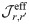
Relative changes in interaction strength due to hidden neurons for three network types.We quantify relative changes in interaction strength between effective (Jr,r′eff) and true (Jr,r′) interactions by the (sample) root-square-mean deviation, σ[Jr,r′eff-Jr,r′], normalized by the true synaptic weight (sample) standard deviation σ[Jr,r′]. We do so for three (sparse) network types: Left. An Erdős-Réyni (ER) network with “mixed synapses” (i.e., Dale’s law not imposed) with normally distributed synaptic weights. Middle. An ER network with Dale’s law imposed, (i.e., each neuron’s outgoing synaptic weights all have the same sign). Right. A Watts-Strogatz (WS) small world network with 30% rewired connections and mixed synapses. All network types yield qualitatively similar results. In each plot solid lines are numerical estimates of the sample standard deviation of the difference between effective coupling weights Jr,r′eff and true coupling weights Jr,r′ between neurons r ≠ r′, normalized by the standard deviation of Jr,r′. These estimates account for all paths through hidden neurons. Purple lines correspond to synaptic weights with standard deviation J0/pN (strong coupling), while grey lines correspond to synaptic weights with standard deviation J0/pN (weak coupling). For weak 1/N coupling (grey), the ratio of standard deviations is O(1/N). For strong 1/N coupling (purple) the ratio is O(1) and grows in strength as the fraction of recorded neurons Nrec/N decreases or the typical synaptic strength J0 increases. The dashed black lines in the left plot show theoretical estimates accounting only for hidden paths of length-3 connecting recorded neurons (Eq (4). Deviations from the length-3 prediction at small f and large J0 indicate that contributions from circuit paths involving many hidden neurons are significant in these regimes.